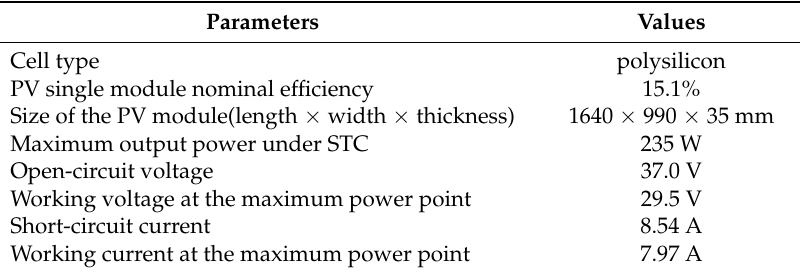
Table 7. Daily air quality of Baoding, China, 14–23 December 2016.